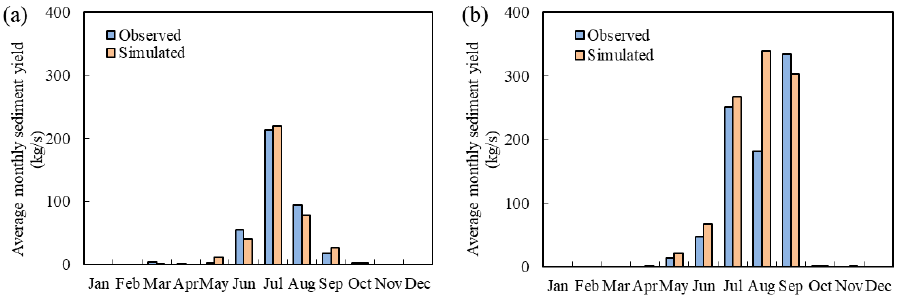
Figure 6. Comparison of average simulated and observed monthly sediment yields for ( a ) the 1980s and ( b ) the 2010s.